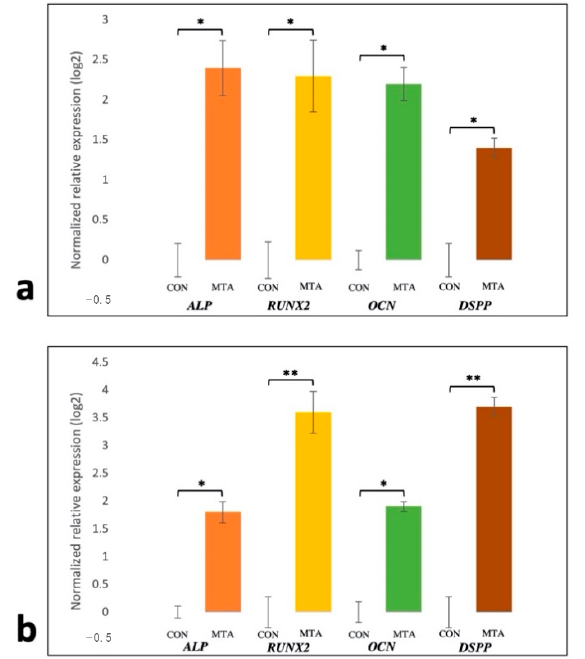
Figure 6. Expression of osteo / odontogenic gene markers (ALP, RUNX2 , OCN , and DSPP ) in human MSCs after 14 days of incubation in 0.2 mg / mL MTA-conditioned media. All gene markers were significantly upregulated compared to the corresponding control group. The rate of increase in the expression of RUNX2 and DSPP was higher in Ad-MSCs ( b ) than BM-MSCs ( a ). GAPDH was used as an internal control. Values are mean ± SD, n = 3; * and ** indicate p values less than 0.05 and 0.01, respectively.